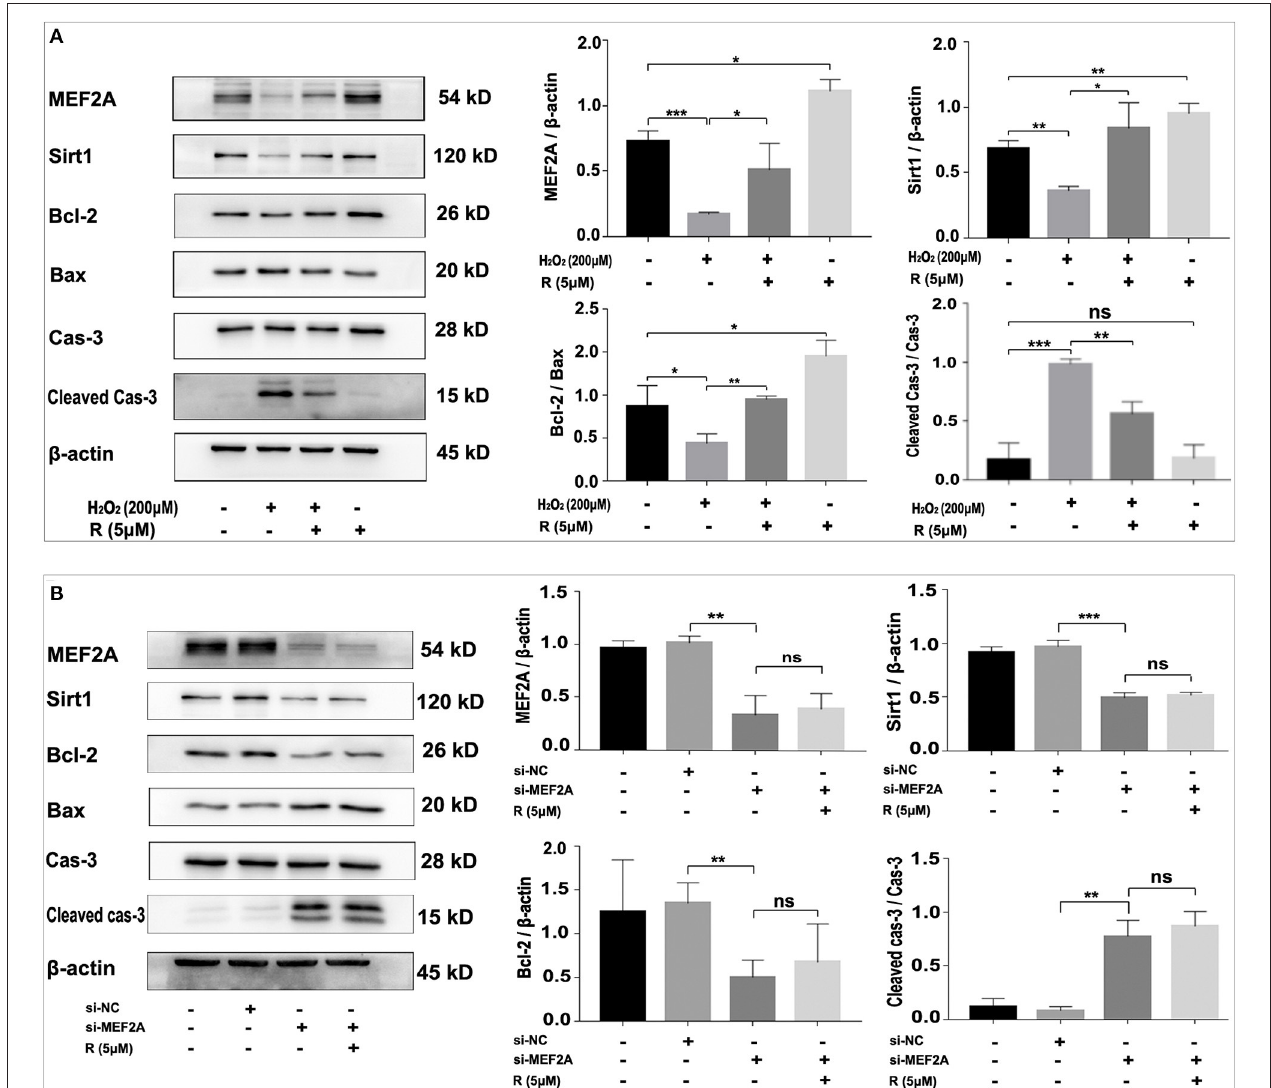
FIGURE 6 | Resveratrol eliminates the alteration of apoptosis-related proteins caused by treatment with H 2 O 2 but not with down-regulation of MEF2A with siRNA. (A) Immunoblots of MEF2A and apoptosis-related proteins for the groups that were treated with H 2 O 2 and resveratrol, solely or together. (B) Using immunoblots to detect alteration of the apoptosis-related proteins caused by silencing MEF2A with siRNA and treatment with resveratrol. Quantification of the band intensity was performed via image-J and values were normalized to beta-actin. R, resveratrol; Cas-3, caspase-3; Si-NC, the negative control of siRNA; Si-MEF2A, MEF2A specific siRNA. All experiments were performed independently for three times. Mean ± SD is represented as bar plot. The statistical significance is analyzed by the unpaired Student’s two-tailed t -test. ns, no significance; * P < 0.05; ** P < 0.01; *** P < 0.001 between groups